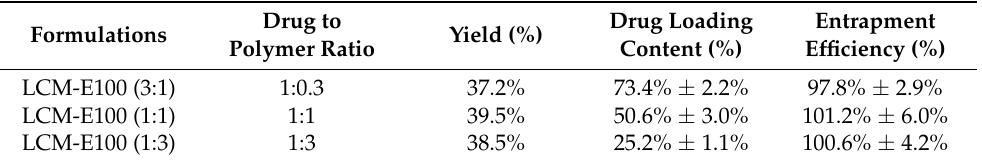
Table 1. Formulation design, yield, drug loading content (%), and entrapment efficiency of the prepared formulations.